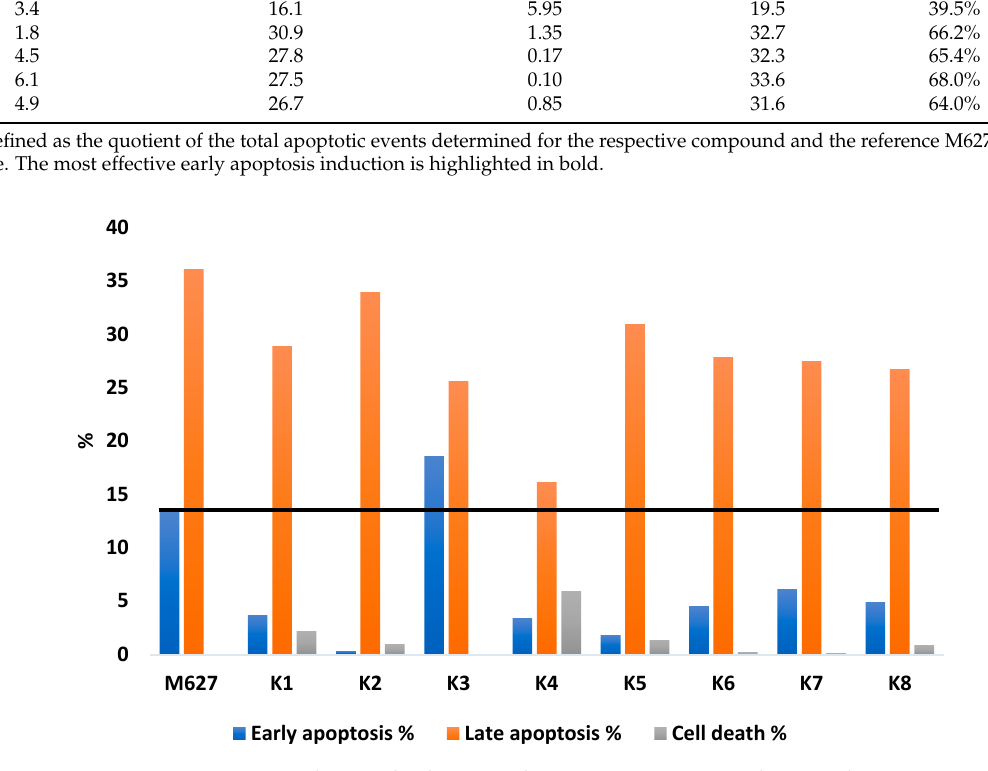
Figure 4. Apoptosis induction by ketone-selenoesters on MDR Colo 320 adenocarcinoma cells. The 12 H - benzo( α )phenothiazine (M627) was applied as a positive control. The cell populations were analysed by flow cytometry after Annexin V-FITC and propidium iodine staining. The figure represents the percentage of early apoptotic cells (annexin positive, propidium iodide negative); late apoptotic cells (annexin positive, propidium iodide positive) (A+, PI+); and dead cells (annexin negative, propidium iodide positive) (A − , PI+). The black line demonstrates the percentage of early apoptosis in the presence of the positive control M627.